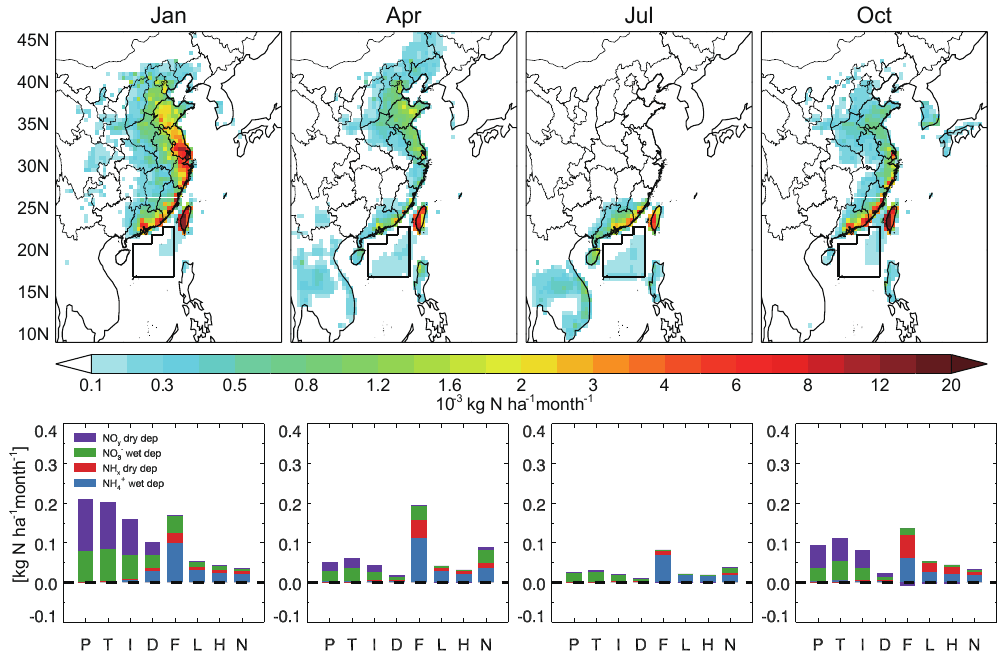
Figure 12. Same as Fig. 11 but for the South China